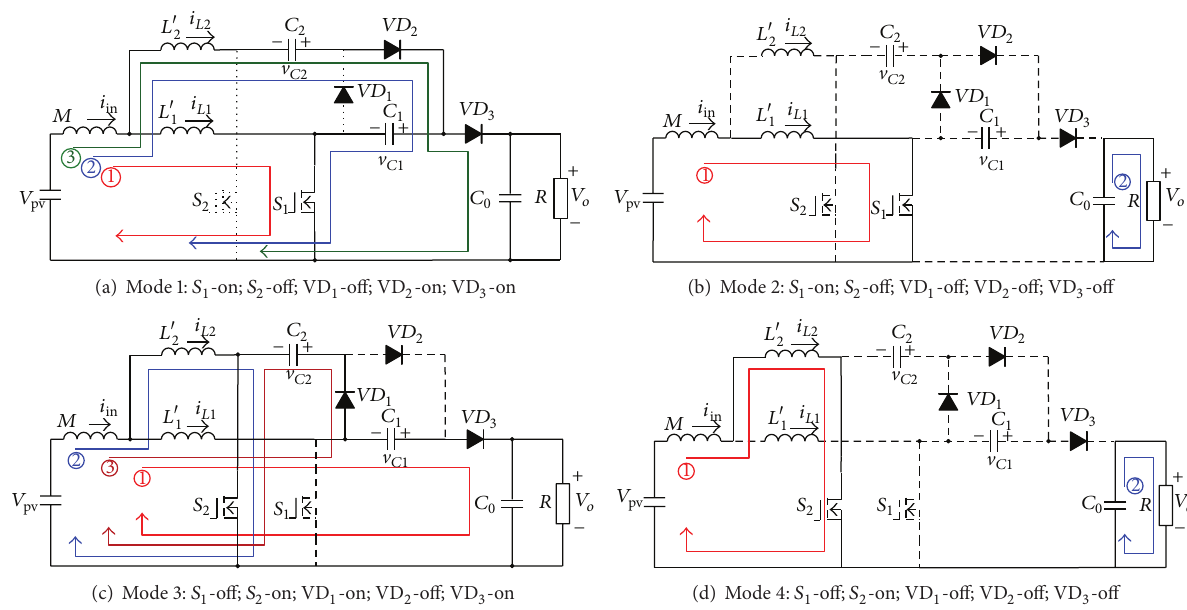
Figure 4: Operation states and current paths of the converter.